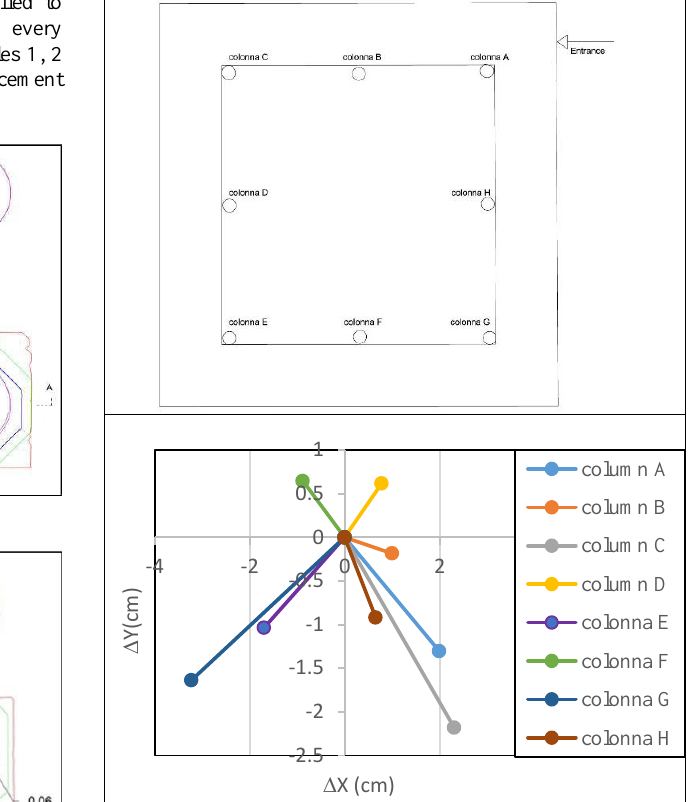
Figure 7. Displacements of a ground floor columns